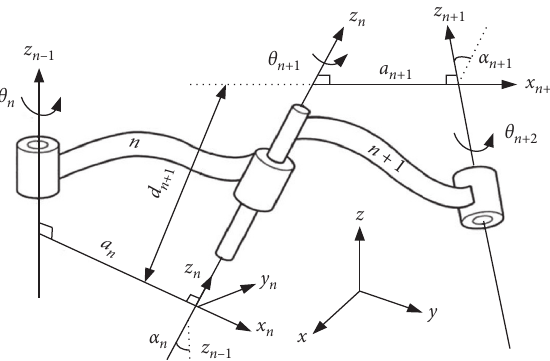
Figure 2: The schematic diagram of the D-H modeling